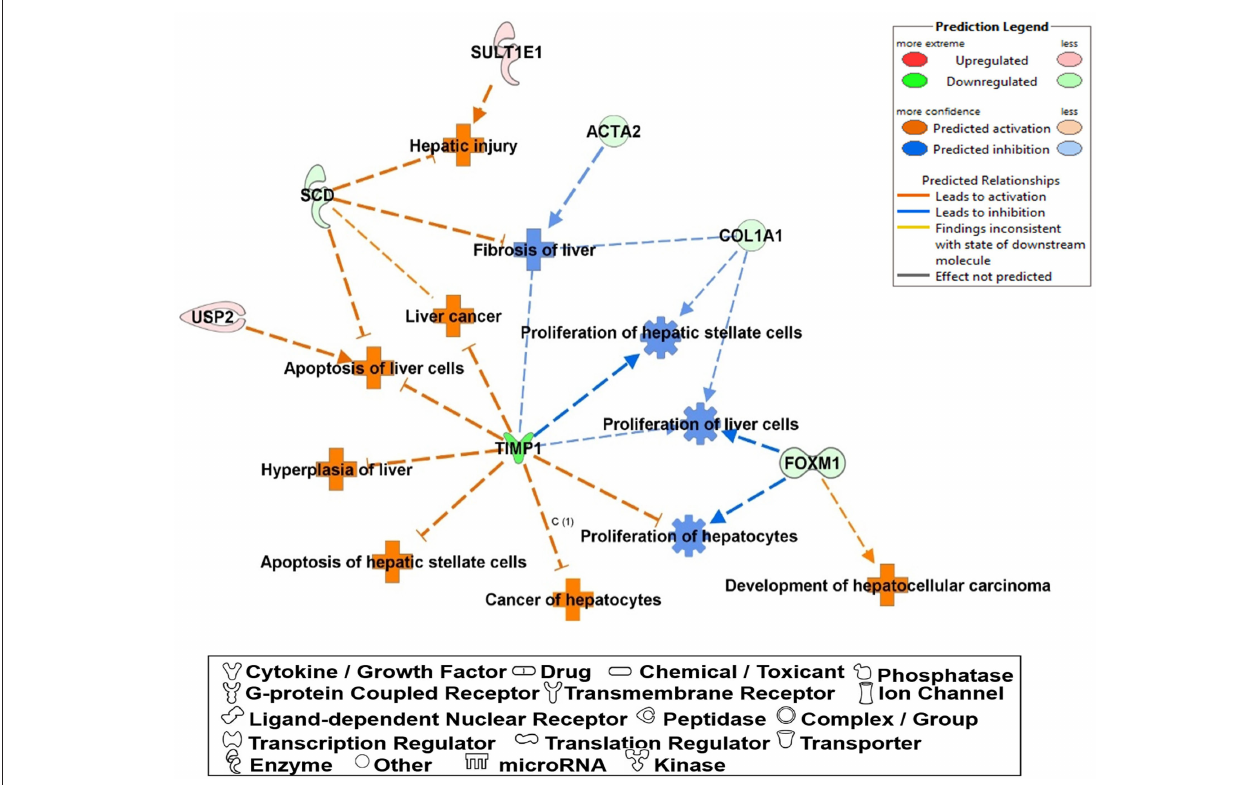
FIGURE 4 | A network of DE genes affecting functions related to “hepatotoxicity” between Phb1 + / − and WT. Red, green, orange, and blue represent upregulation and downregulation, predicted upregulation, and predicted downregulation,